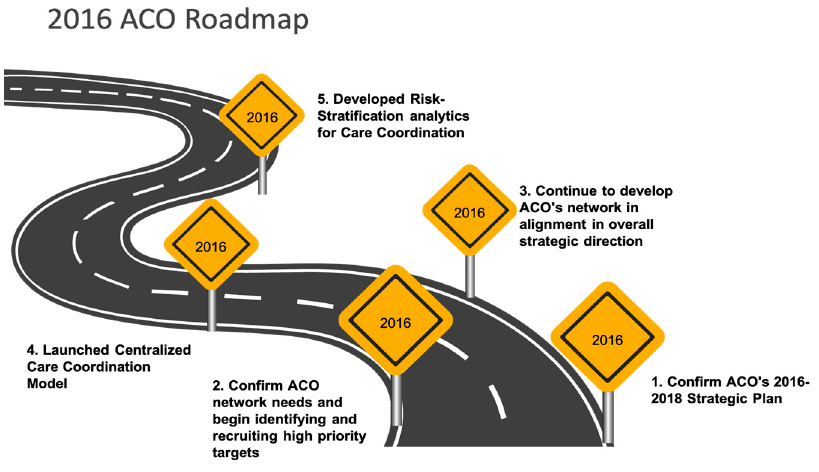
Figure 1. 2016 M-ACO Roadmap Reaffirms Strategic Approach and Confirms Strategic Plan (2016–2018).